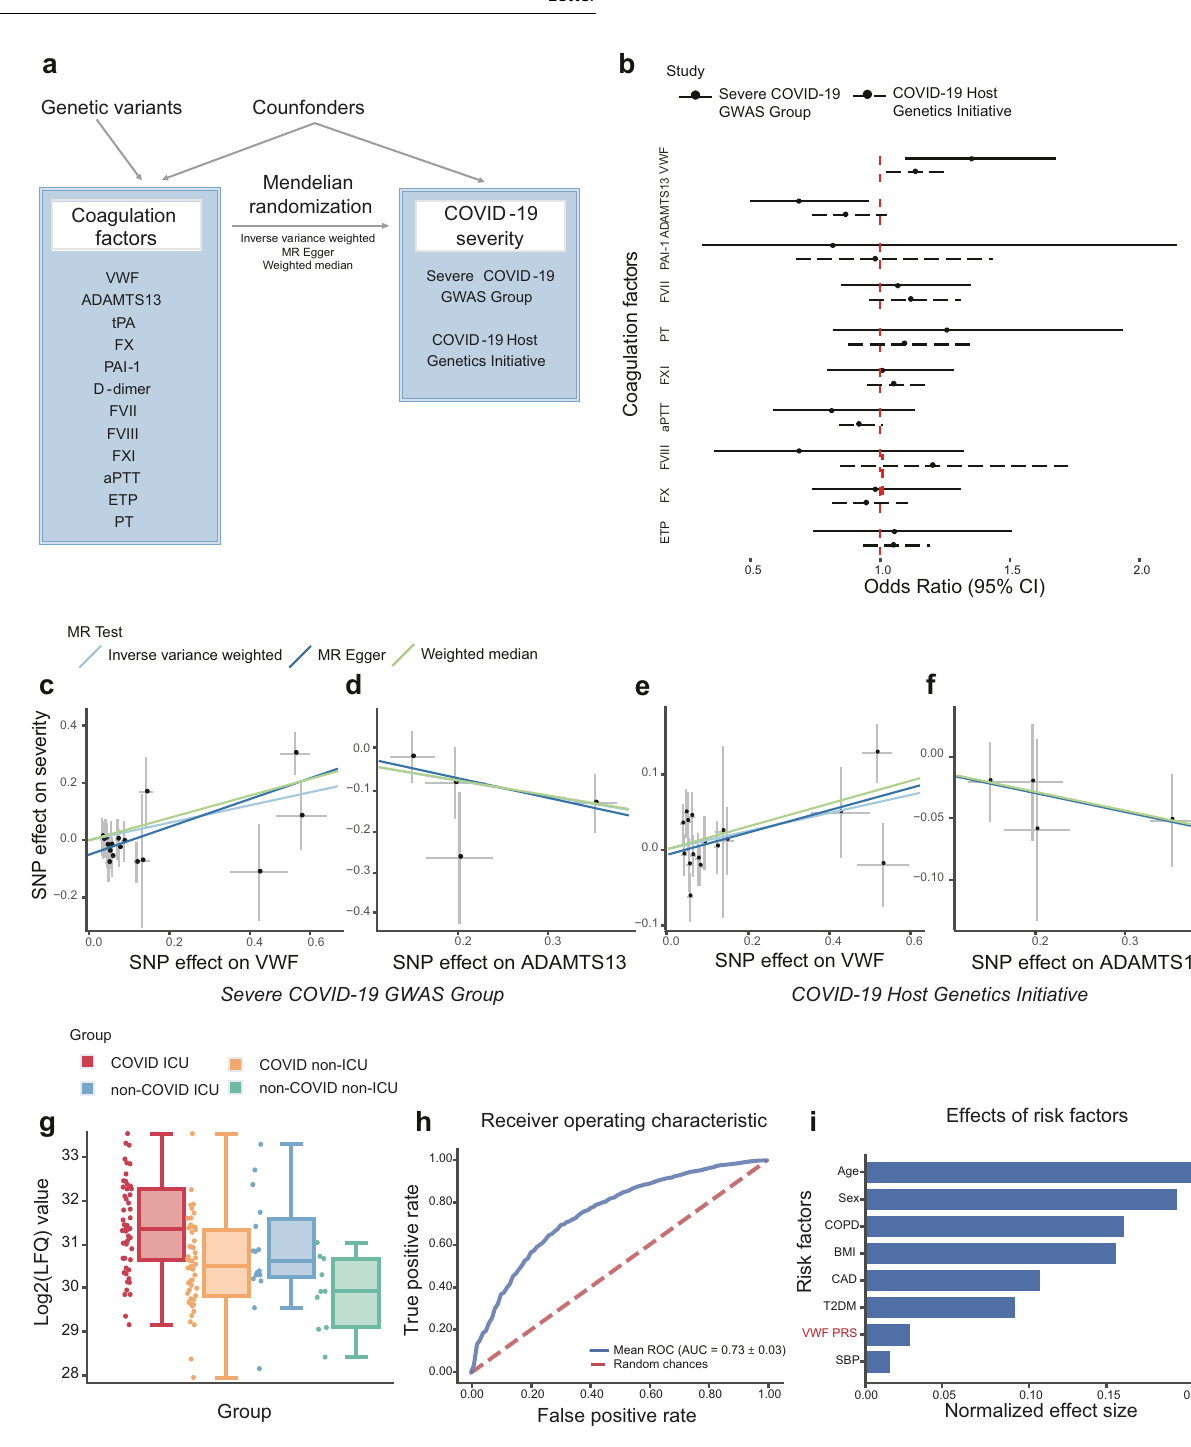
Furthermore, to investigate the prediction performance of the overall COVID-19 severity model and the contribution of VWF PRS, we calculated the area under the receiver operating characteristic curve (AUC) by 10-fold cross-validation. We found that the model combining clinical risk factors and the VWF PRS received a mean AUC of 0.734 (±0.03) (Fig. 1h), and the VWF PRS moderately increased the mean AUC by 0.3% when compared with the model based on only clinical parameters. Since we